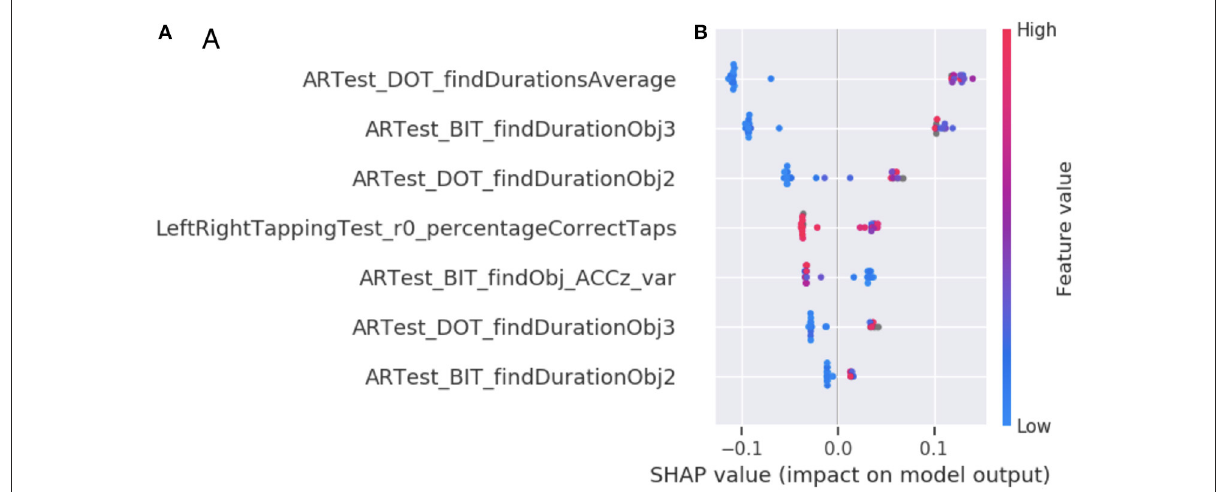
FIGURE4 Feature importance of the DNS-br classifier. (A) The top seven digital biomarker groups according to the SHAP method. Each bar represents the summed SHAP value of the features in that feature group. (B) A feature value SHAP distribution plot for the top seven contributing features. Subject specific SHAP values were computed for each datapoint in the classifier training data. For each feature, we then plot for each datapoint a dot with the feature value of that datapoint, with the dot color coded by the relative feature value. On the left side we observe each feature ordered according to its importance. The perimeter feature being the most important and texture feature being the least important. The color represents the values that each feature can take, red for high values and blue for low values. Therefore, for the feature DOT average find durations, if the values are high (red) the Shapley values will be low and consequently it will be pushing toward class 0 (or high brain resilience and remaining stable at 80 + ), otherwise, when the values are low (blue) the Shapley values they will be high that consequently they will be pushing toward class 1 (or low brain resilience and potential cognitive change at 80 + ). The position of each dot on the SHAP value x-axis represents the magnitude and the direction of the contribution of that specific feature value of that specific datapoint toward classifying as resilient (-1) or non-resilient ( + 1). Acronyms in the plots are Augmented Reality (AR), Day out Task test (DOT), Back in Time test (BIT), Accelerometer (ACC), variance (var), first part of a single test (1st) or second part of a single test